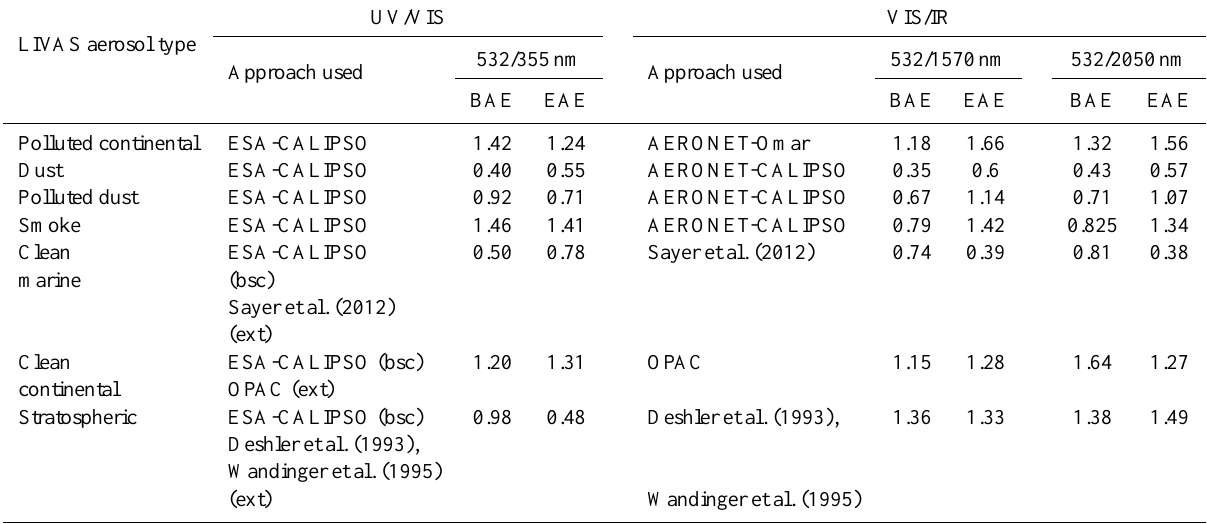
Table 2. BAE and EAE for each aerosol type used in LIVAS for the conversion from 532 to 355nm (VIS–UV) and from 532 to 1570 and 2050nm (VIS–IR). The approaches used for their calculation are also indicated. UV/VIS VIS/IR LIVAS aerosol type Approach used